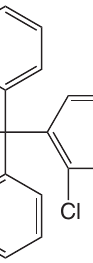
FIGURE 1 - Structure of the azole compound clotrimazole